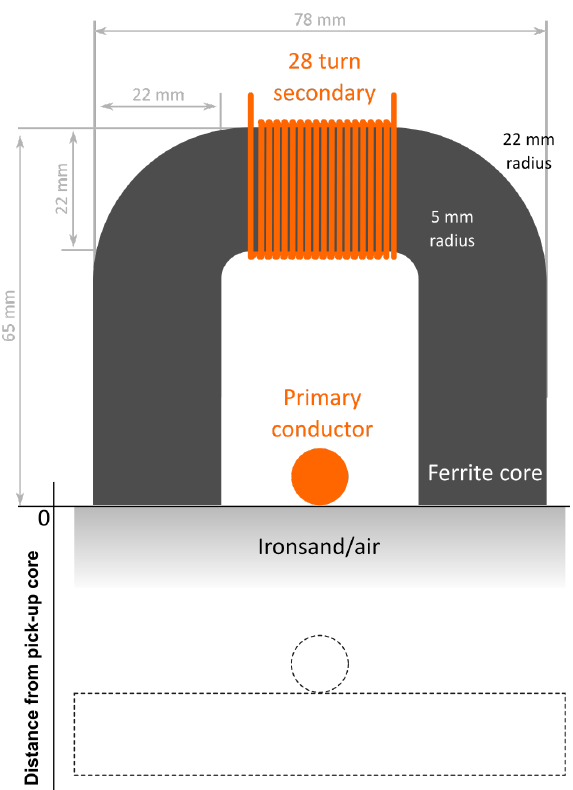
Figure 1. Physical dimensions of the power transfer setup used in this investigation. The dash lines show a different position of the primary circuit with respect to the U-shaped